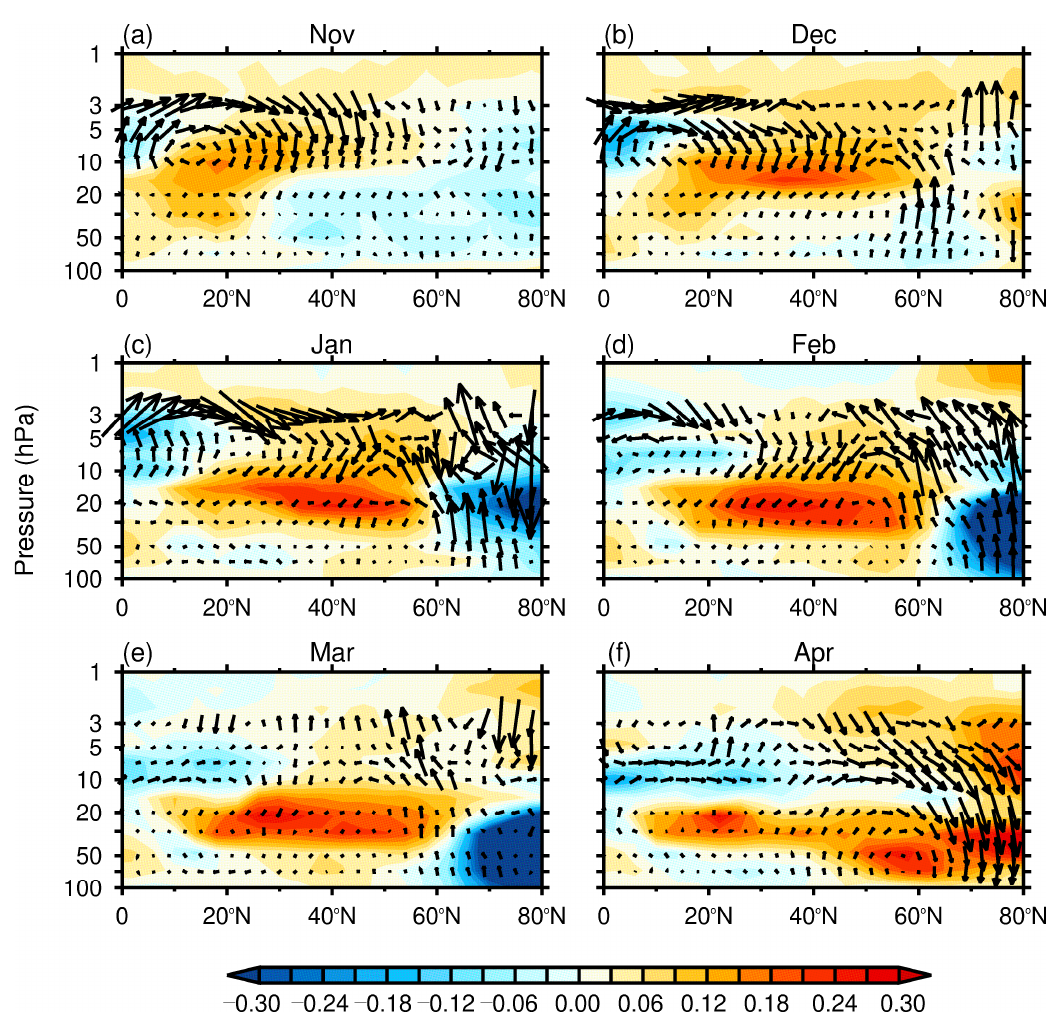
Figure 4. Month ‐ to ‐ month evolution of anomalies of the residual circulation ( 𝑣 ∗ , 𝑤 ∗ , arrows) and HCl (contours) ( a – f ) from November 2010 to April 2011. The vertical component of the residual circulation was multiplied by 500. HCl values are based on MLS data.